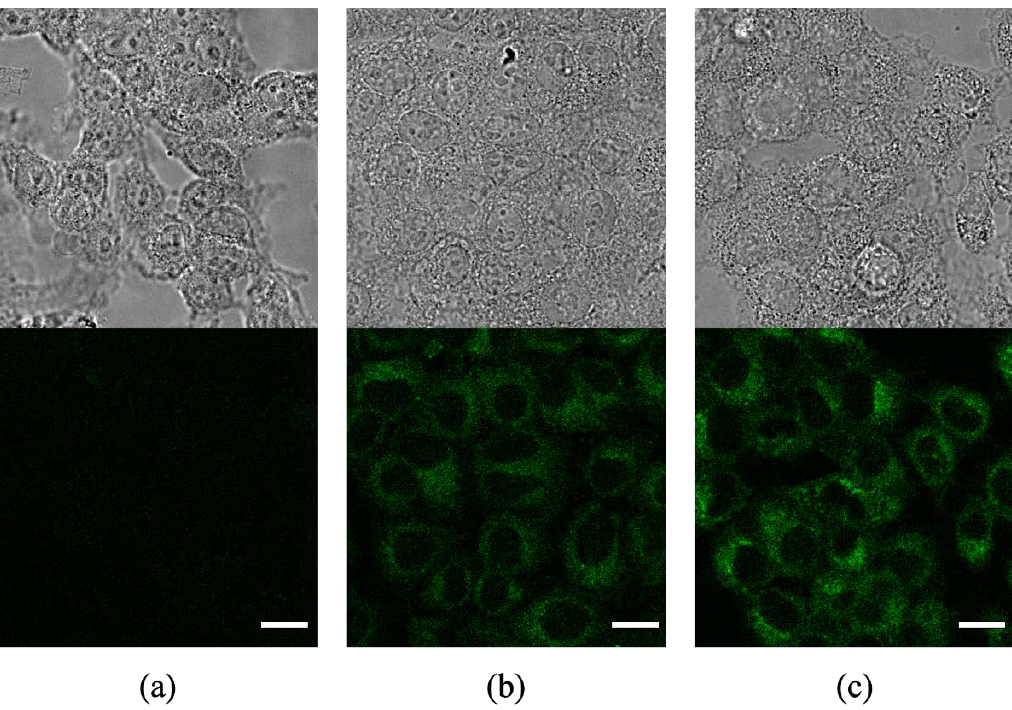
Figure 5. Confocal fluorescence images of HeLa cells without incubation with photosensitizers ( a ) and after incubation with Ce6 ( b ) and Ce6-biotin ( c ). Scale bars: 20 µm.